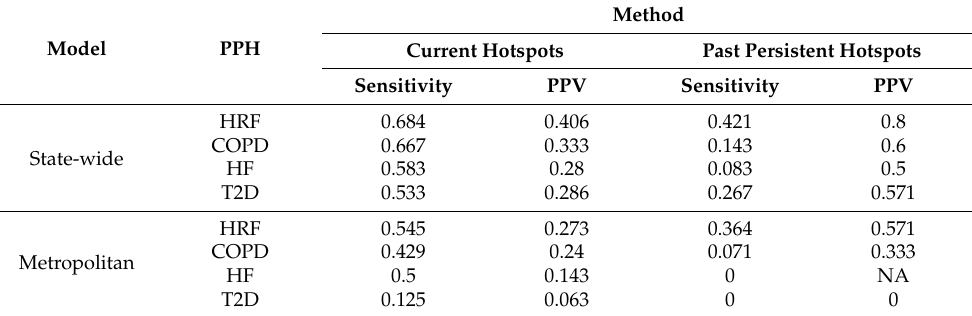
Table 4. Validation performance statistics for the “current hotspots” and “past persistent hotspots” prediction